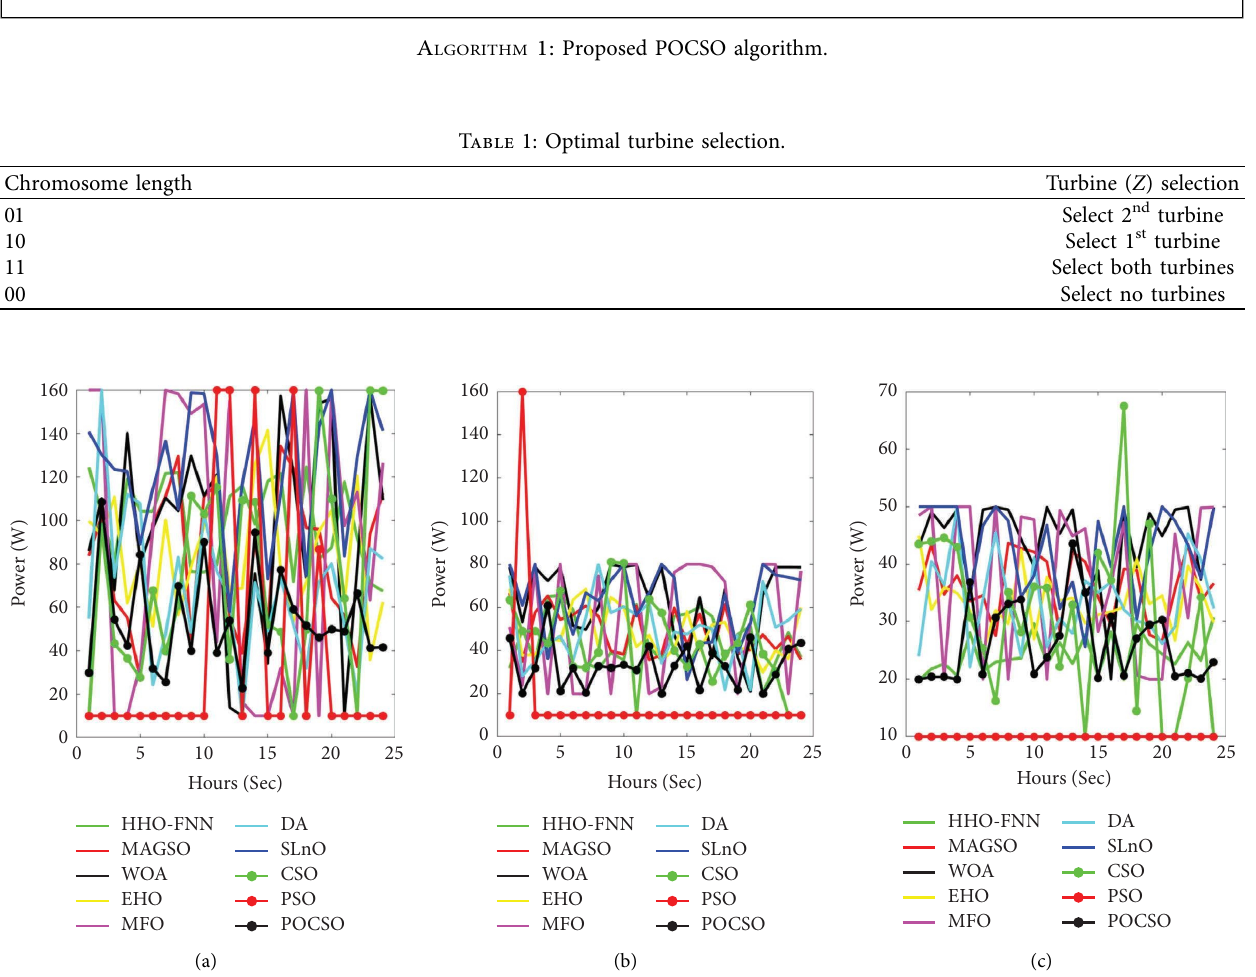
Figure 5: Optimal power generation bounds for IEEE-14 bus system of the proposed and existing methods for (a) Gen 1, (b) Gen 2, and (c) Gen